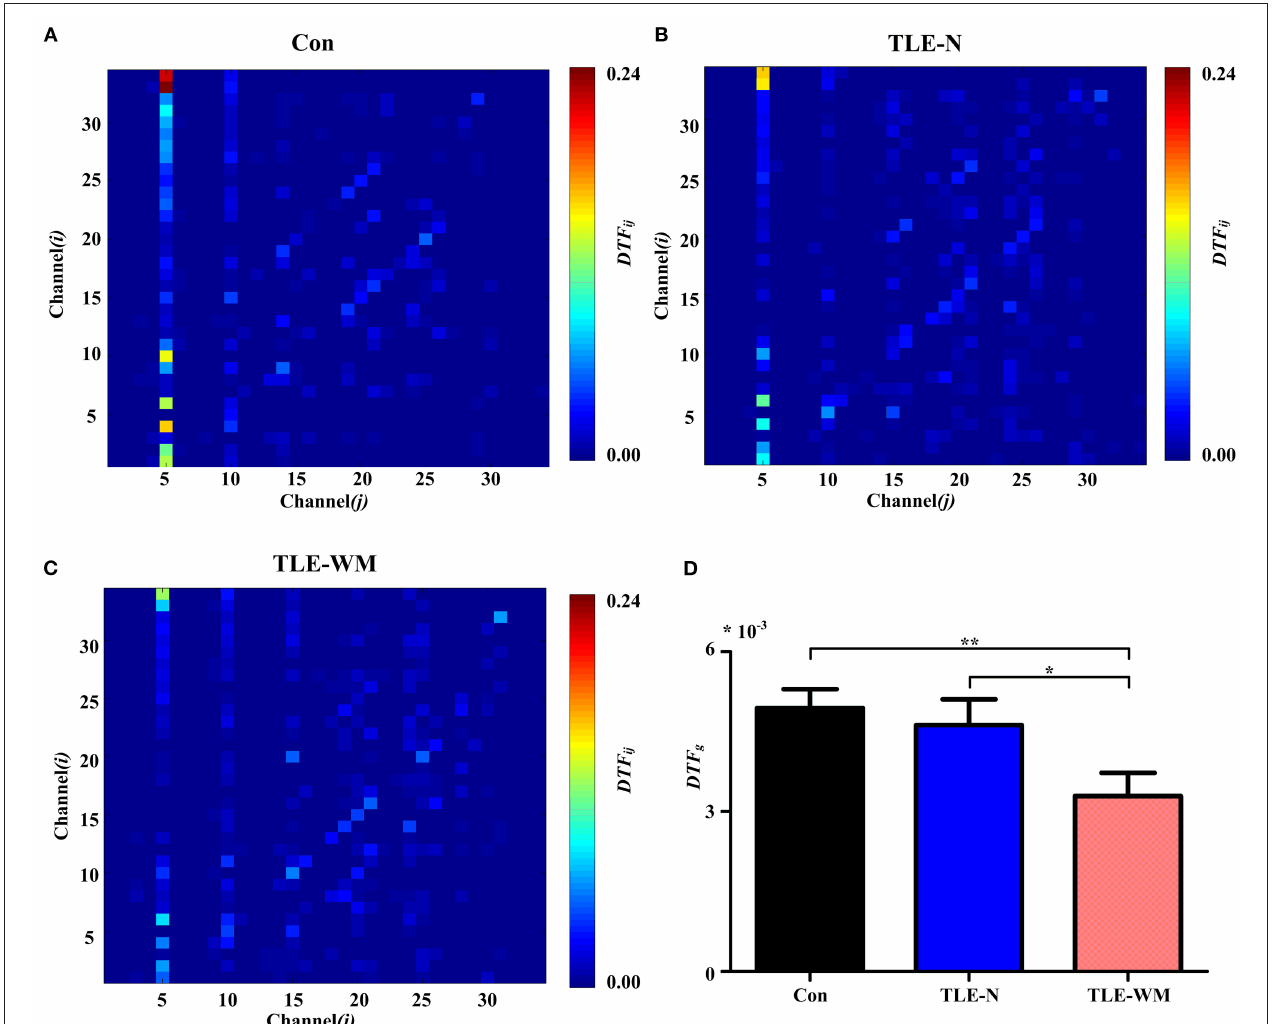
FIGURE 5 | Functional connectivity across channels during the WM encoding phase. Connectivity matrices of EEGs in the Con group (A) , TLE-N group (B) , and TLE-WM group (C) . Nodes 1–34 represent Channels 1–34 (i.e., Fp1, Fp2, F7, F3, Fz, F4, F8, FT7, FC3, FCz, FC4, FT8, T7, C3, Cz, C4, T8, TP7, CP3, CPz, CP4, TP8, P7, P3, Pz, P4, P8, PO3, PO4, O1, Oz, O2, AF3, and AF4, respectively). The connectivity strengths from channel j to channel i are represented by the different colors. The connectivity strength in the Fz channel (channel 5) was strong. (D) Comparisons of the average DTF values for 34 channels among the three groups. The average connectivity strength in the TLE-WM group decreased compared with those of the Con group and the TLE-N group. * p < 0.05 and ** p <